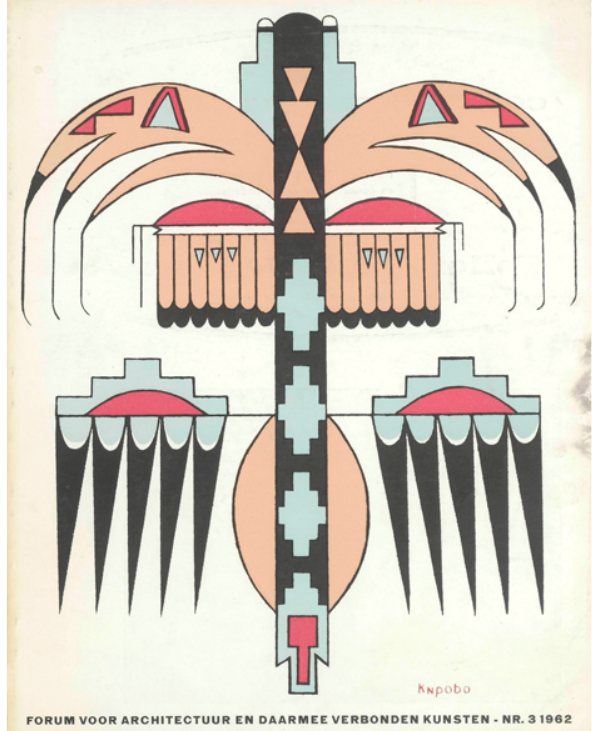
Cover of Forum 1962, n. 3 “The Fake Client and the Great Word ‘No.’” Forum voor Architectuur en Daarmee Ver- bonden Kunsten 16, n. 3